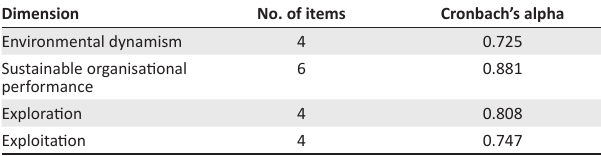
TABLE 1: Reliability statistics for the five dimensions